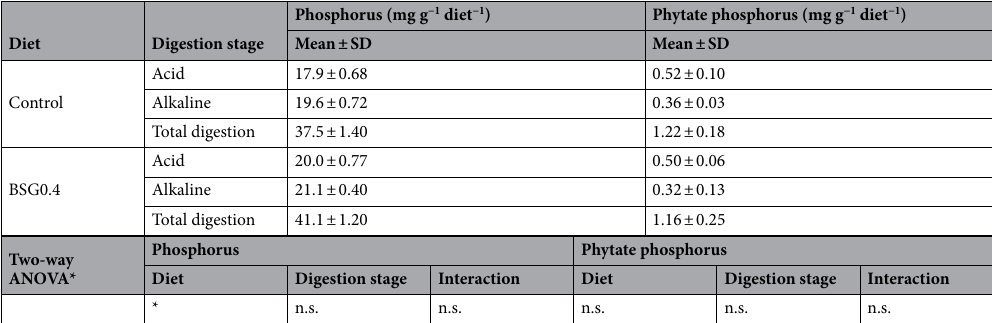
Table 3. Total and phytate phosphorus release of control and BSG0.4 diets during in vitro digestion (assay 1). Values presented as mean (n = 3) and standard deviation (SD). Two-way ANOVA testing for the effect of the diet (control and BSG0.4) and digestion stage (acid, alkaline and total). * p < 0.05; ** p < 0.01; *** p < 0.001; n.s.: not significant.